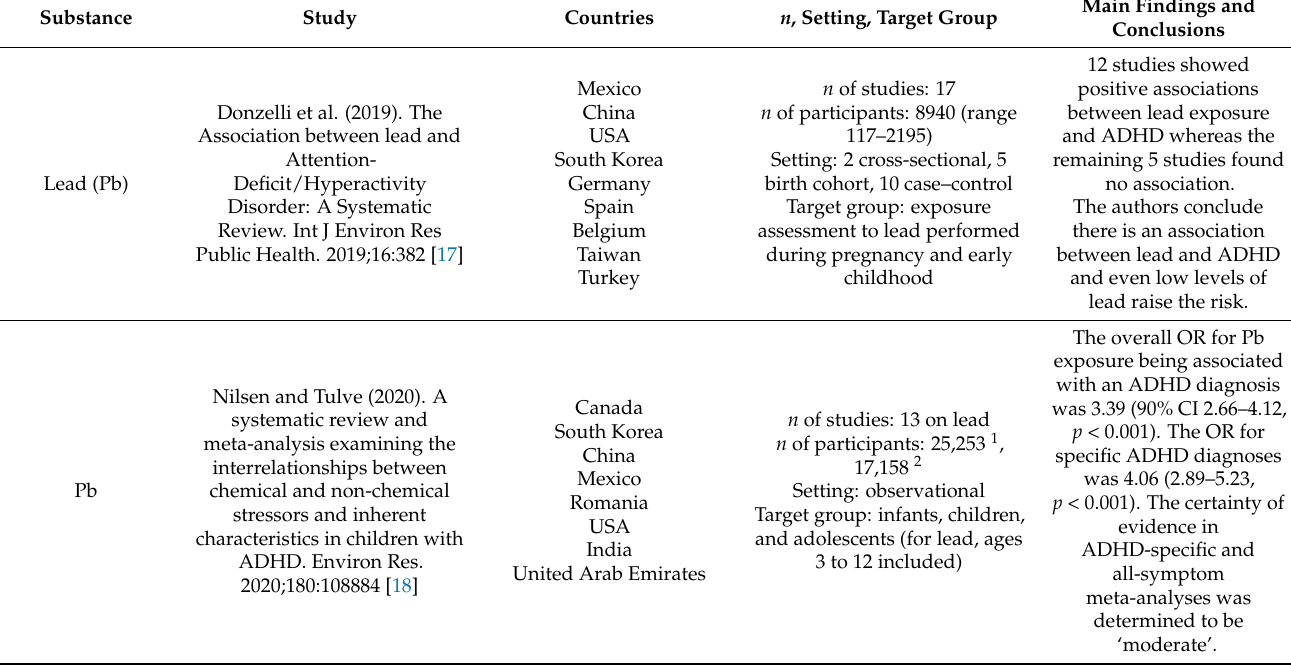
Table 1. Summary of studies providing moderate to high evidence of the association between ADHD and each of lead (Pb), phthalates (PhPl) and bisphenol A (BPA). Countries n , Setting, Target